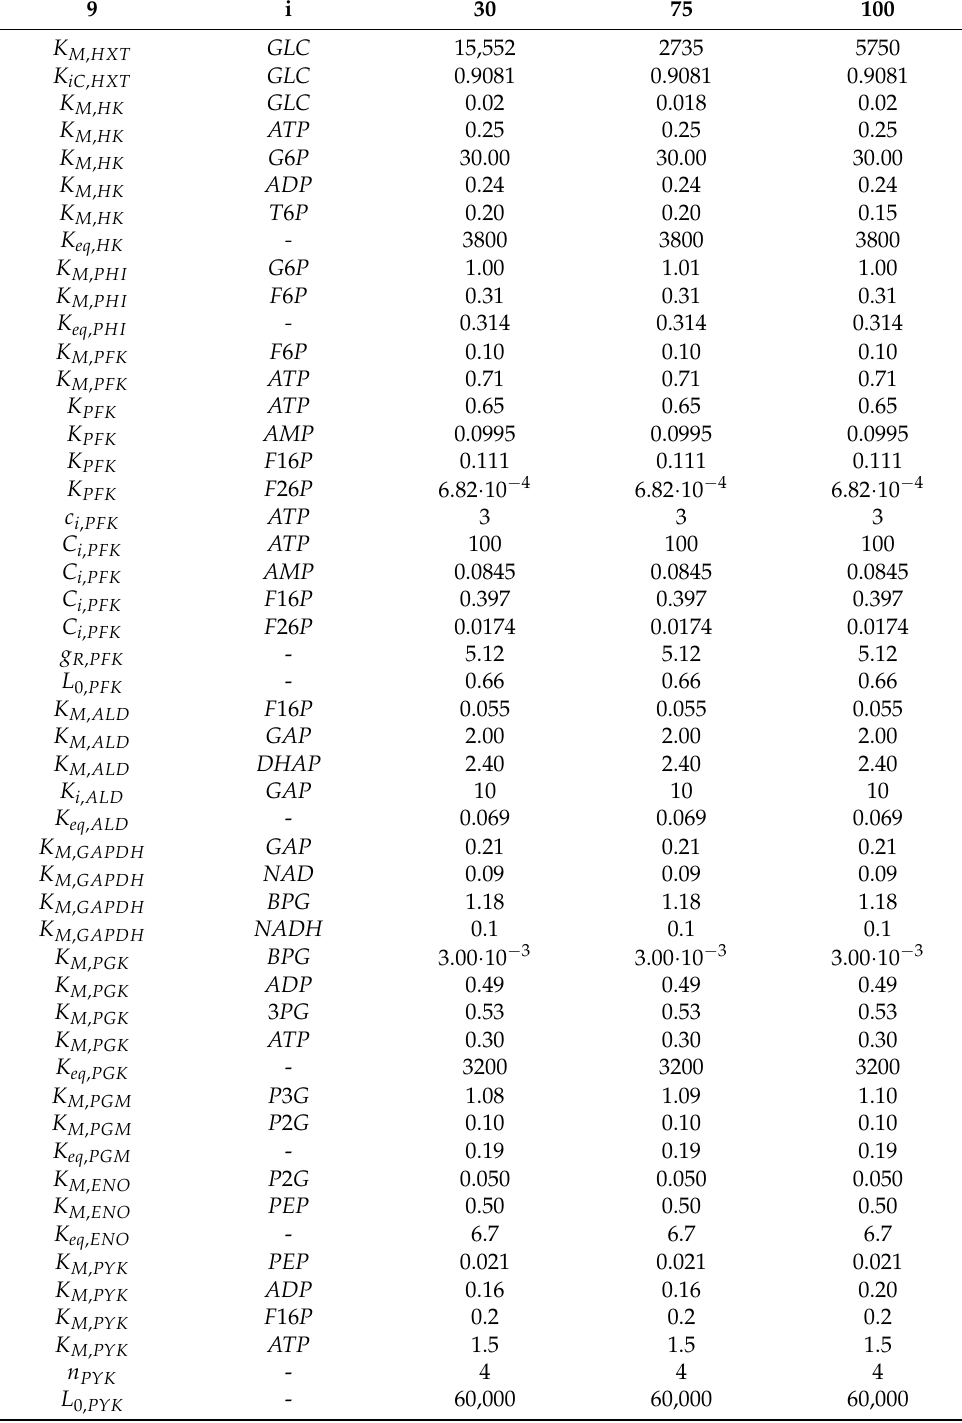
Table A2. Apparent saturation constants K (mM), equilibrium constants, and other constants of the SR and CR models as a function of the substance i according to the initial concentration of fermentation in g L − 1